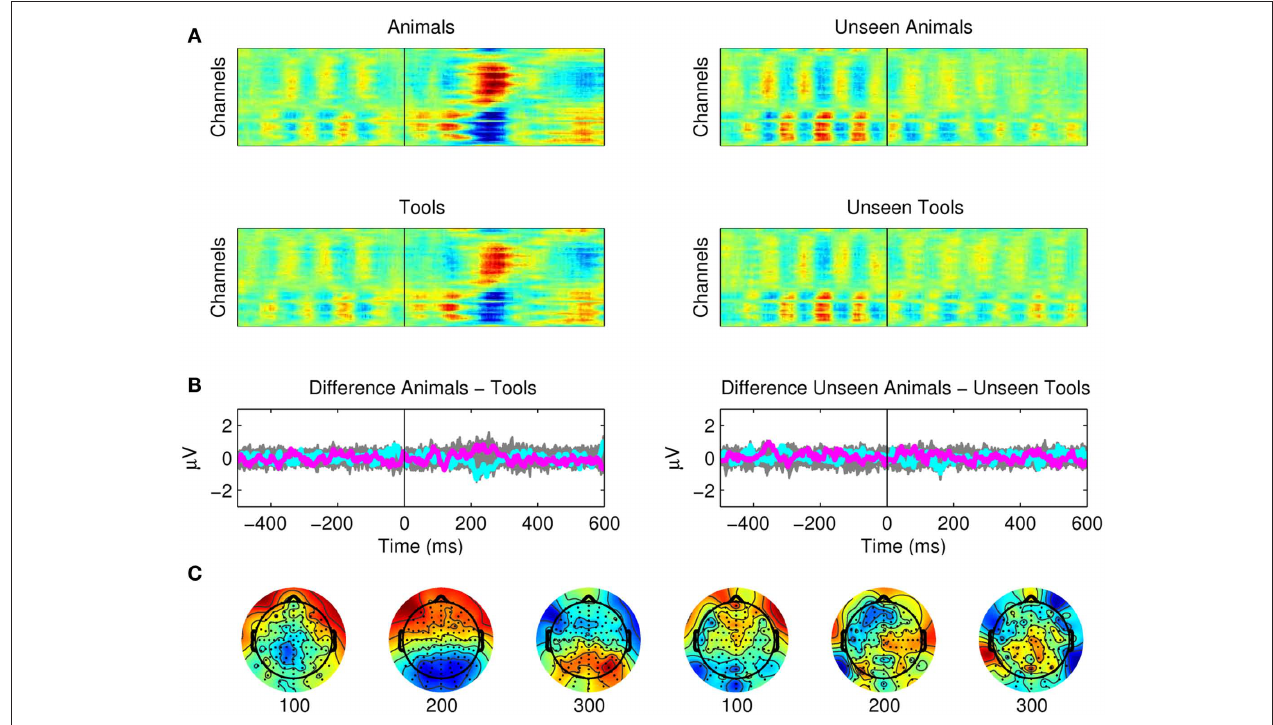
plotted for all channels (gray) and as particular examples for channel “OZ = cyan” and “FZ = magenta.” The activity of Mondrians is canceled by the subtraction between conditions. (C) However, even if it was not statistically significant, some type of small potential was still present after the subtraction around 200 ms. We investigated this activity employing a multi pattern analysis approach ( Figure 7) .